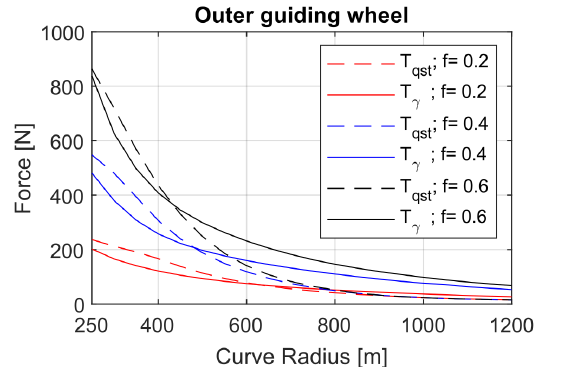
Figure 4. Dependence of the T radius R in defined range of the friction coefficient values µ .